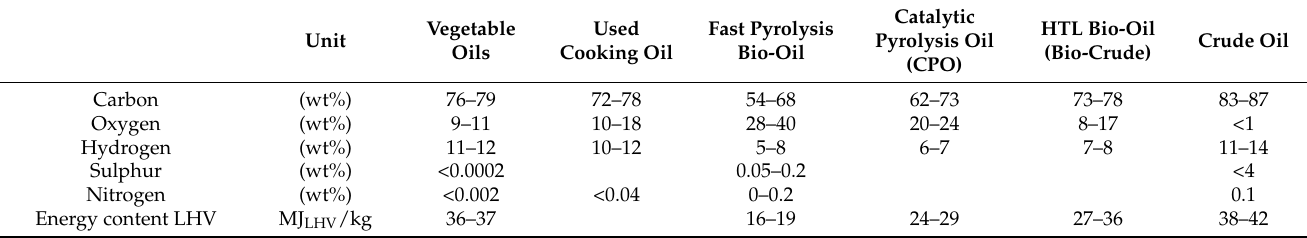
Table 1. Typical composition of biobased feedctocks used for co-processing in refineries.